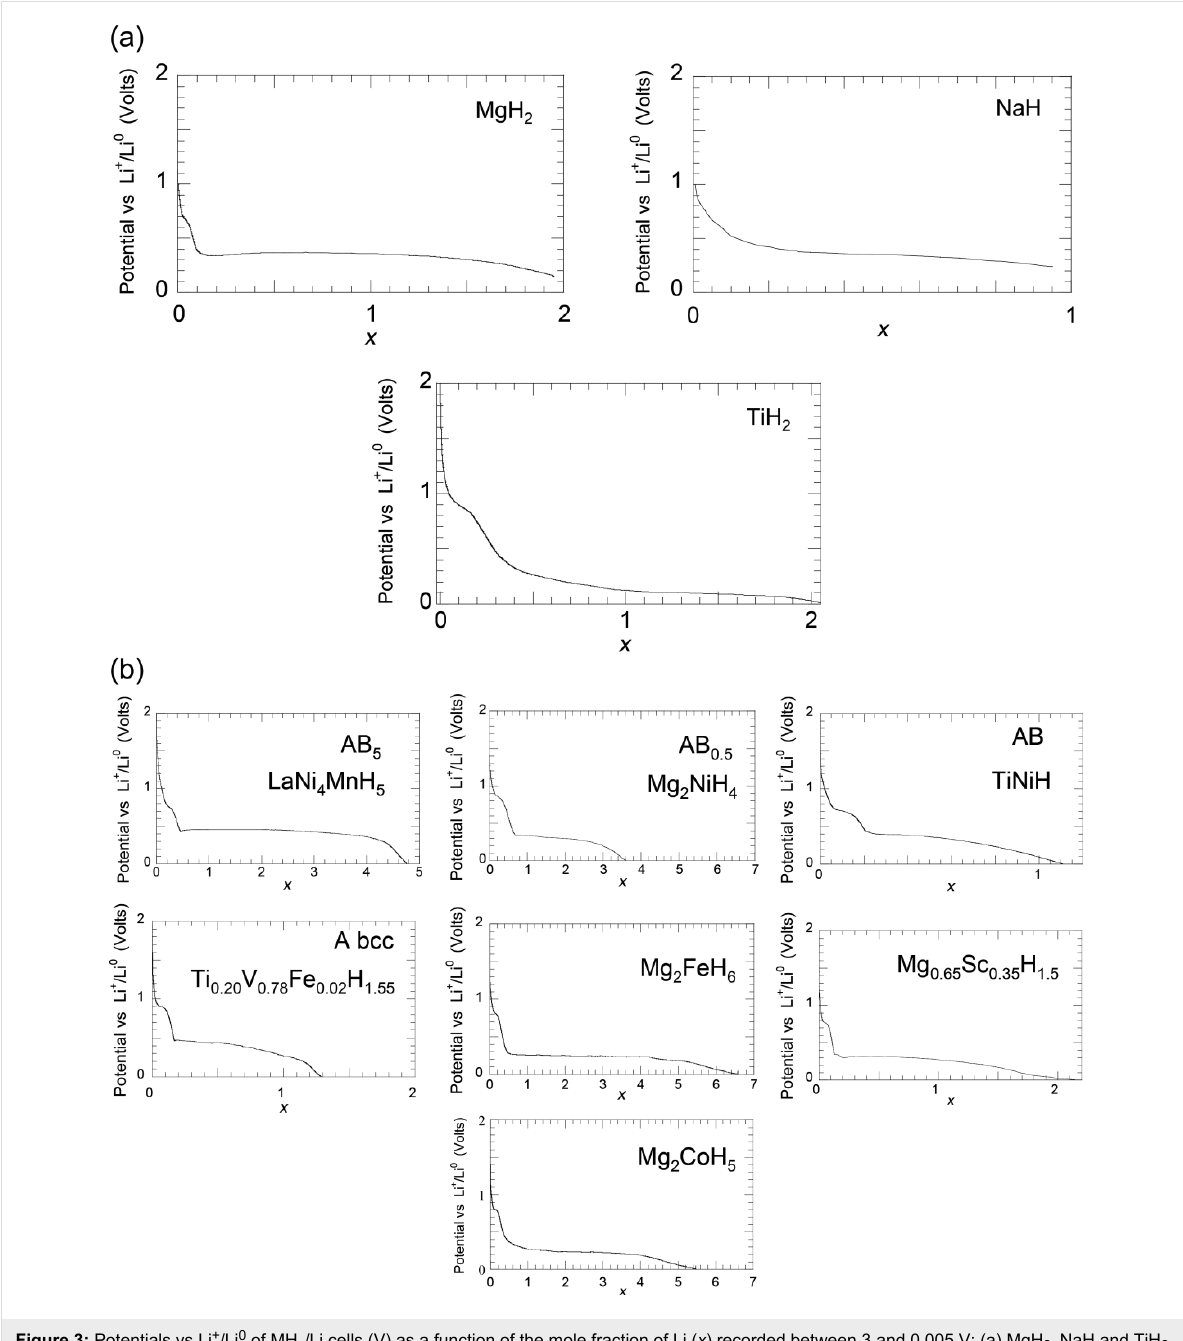
agreement with the formation of a Mg-type solid solution (Figure 4b, no. 6 and Table 1). The last slope corresponds to the formation of a bcc Li-type solid solution (Figure 4b, no. 8), and the plateau to the coexistence of both solid solution types (Li and Mg) (Figure 4b, no. 7). In short, MgH 2 reacts with Li ions to form Mg and LiH within the conversion process MgH 2 + 2Li + + 2e − → Mg + 2LiH at around 0.44 V vs Li + /Li 0